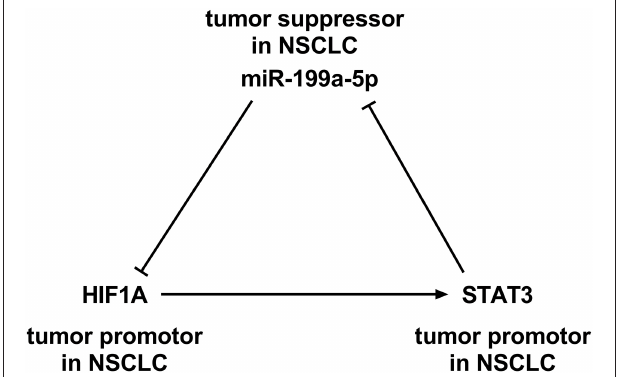
FIGURE 1 | A positive feedback loop among miR-199a-5p, hypoxia-inducible factor-1 α (HIF-1 α ), and signal transducer and activator of transcription 3